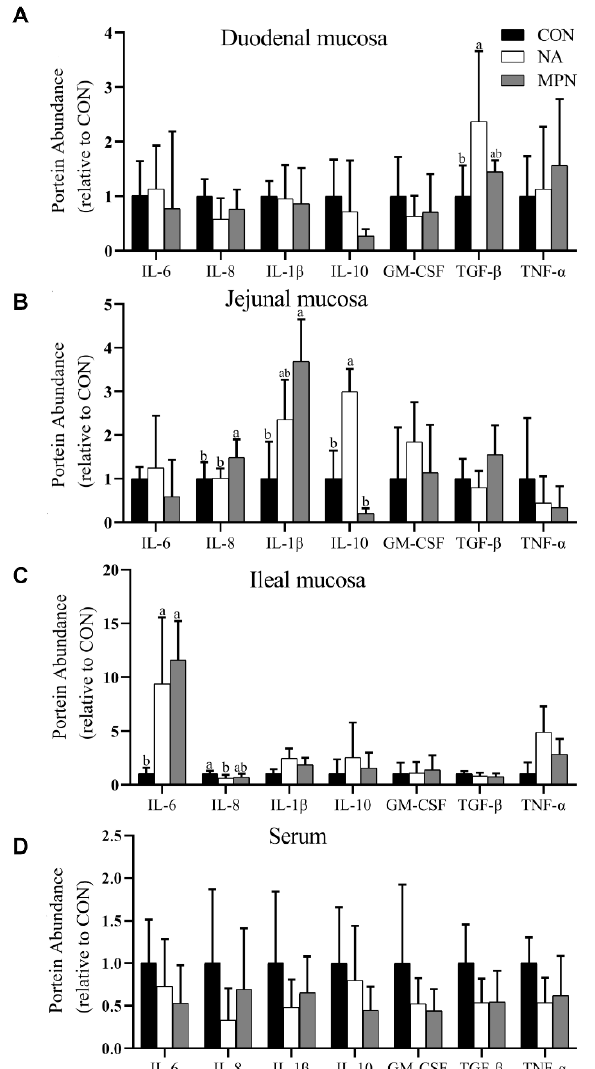
Figure 2. Effect of niacin on the expression of proteins related to the inflammatory response in the small intestinal mucosa and serum of weaned piglets; ( A ) Duodenal mucosa; ( B ) Jejunal mucosa; ( C ) Ileal mucosa; ( D ) Serum. Values are expressed as the mean ± SD, n = 8/treatment. a, b Values of different superscripts in the same row mean significantly different ( p < 0.05). IL-6, interleukin-6; IL-8, interleukin-8; IL-1β, interleukin-1β; IL-10, interleukin-10; GM-CSF, granulocyte-macrophage colony stimulating factor; TGF-β, transforming growth factor-β; TNF-α, tumor necrosis factor-α; CON, control group; NA, niacin group; MPN, GPR109A antagonist group.